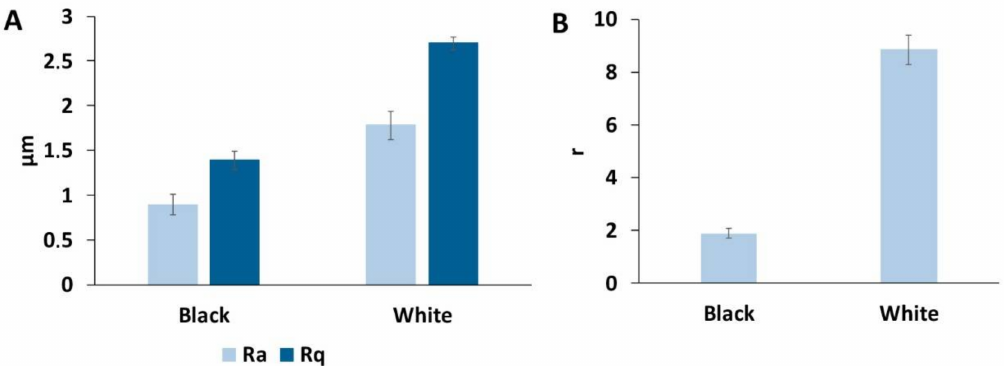
Figure 7. Roughness measurements of the G. orientalis elytra surface. ( A ) Arithmetic mean roughness (Ra) and quadratic mean roughness (Rq) measurement. ( B ) Calculated roughness (r) parameter.